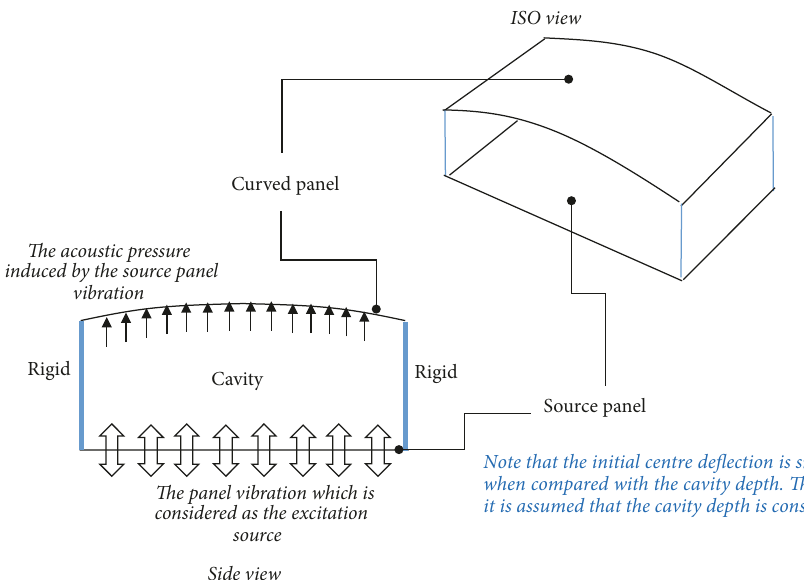
Figure 1: Nonlinear vibroacoustic system: a curved panel backed by a